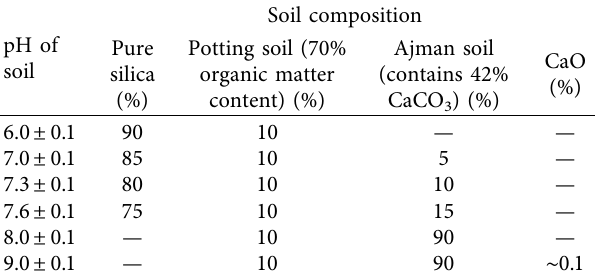
Table 2: Soil composition at different values of